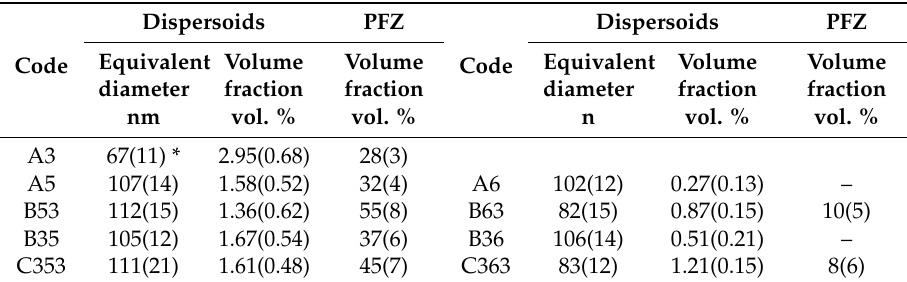
Table 2. Characteristics of dispersoids and PFZ during heat